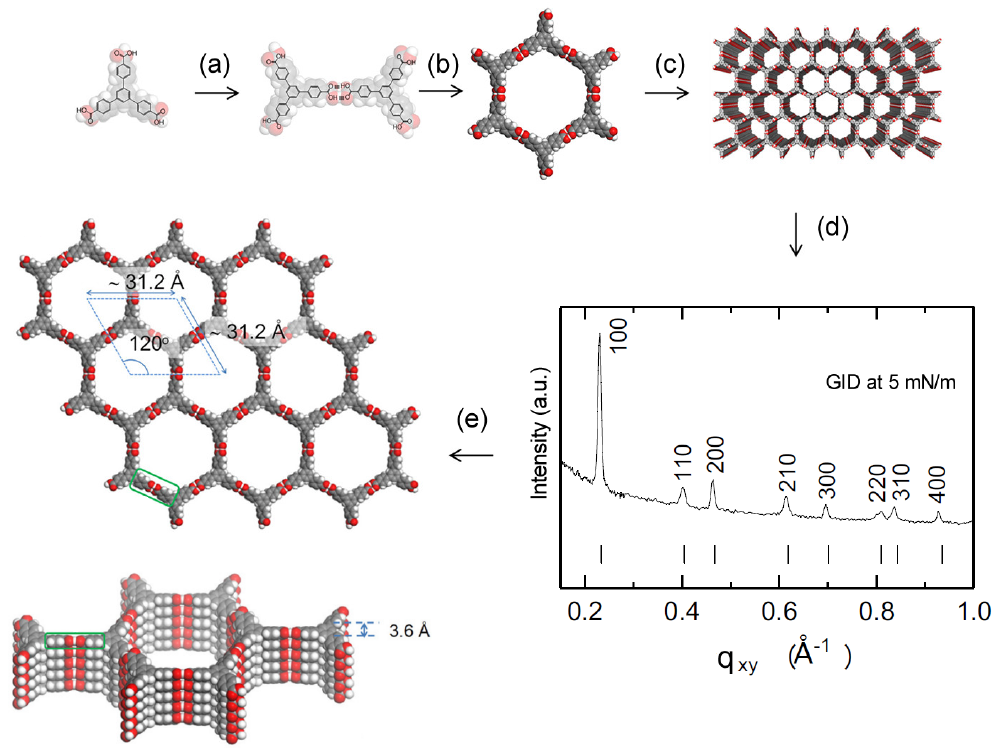
Figure 20. Formation stages of perfectly oriented nanosheets, out of building blocks of (1,3,5-tris-(4-carboxyphenyl)-benzene), with long-range molecular columns, and size-